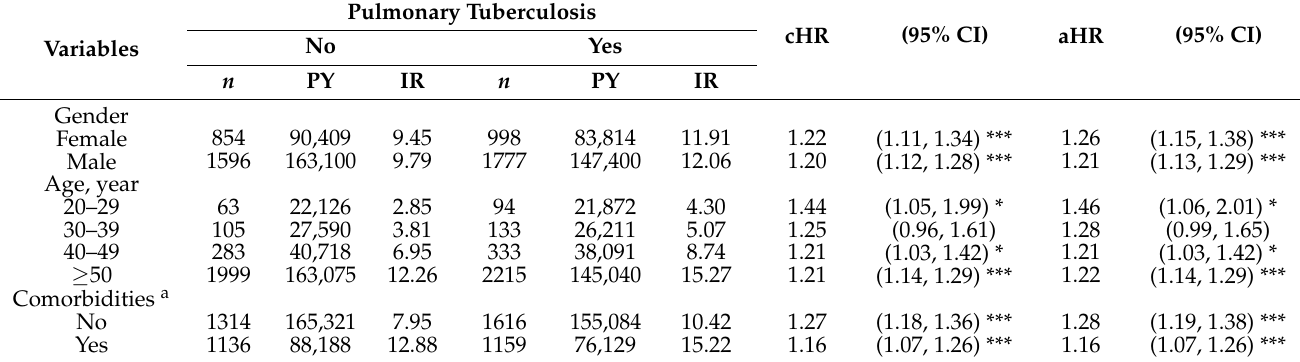
Table 3. Cox proportional hazards regression analysis for the risk of herpes